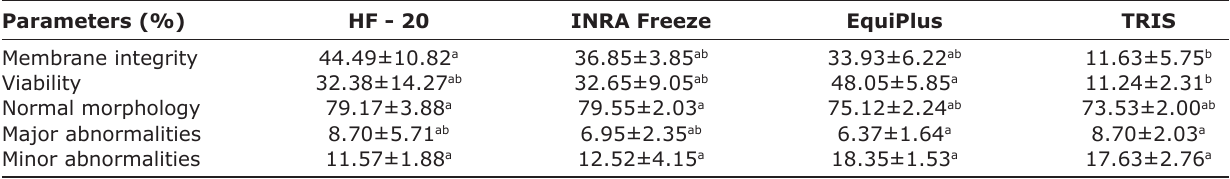
Table-5: Effect of different extenders on the post-thawed stallion semen, the plasma membrane integrity, viability, and morphology. Parameters